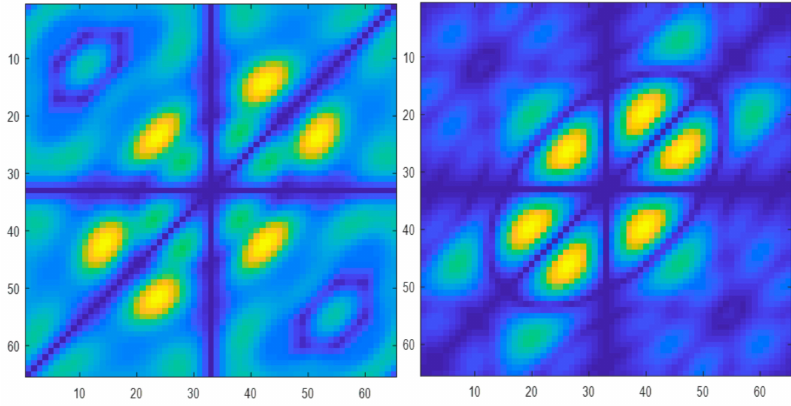
Figure 6. Bispectrum plots of ( a ) normal and ( b ) ASD classes (channel 50).